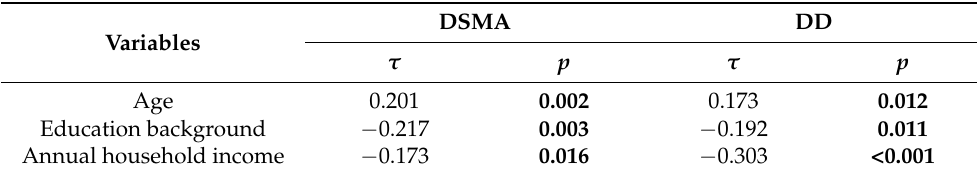
Table 2. Kendal’s Tau analysis between DSMA and DD and variables. DSMA DD Variables τ p τ p Age